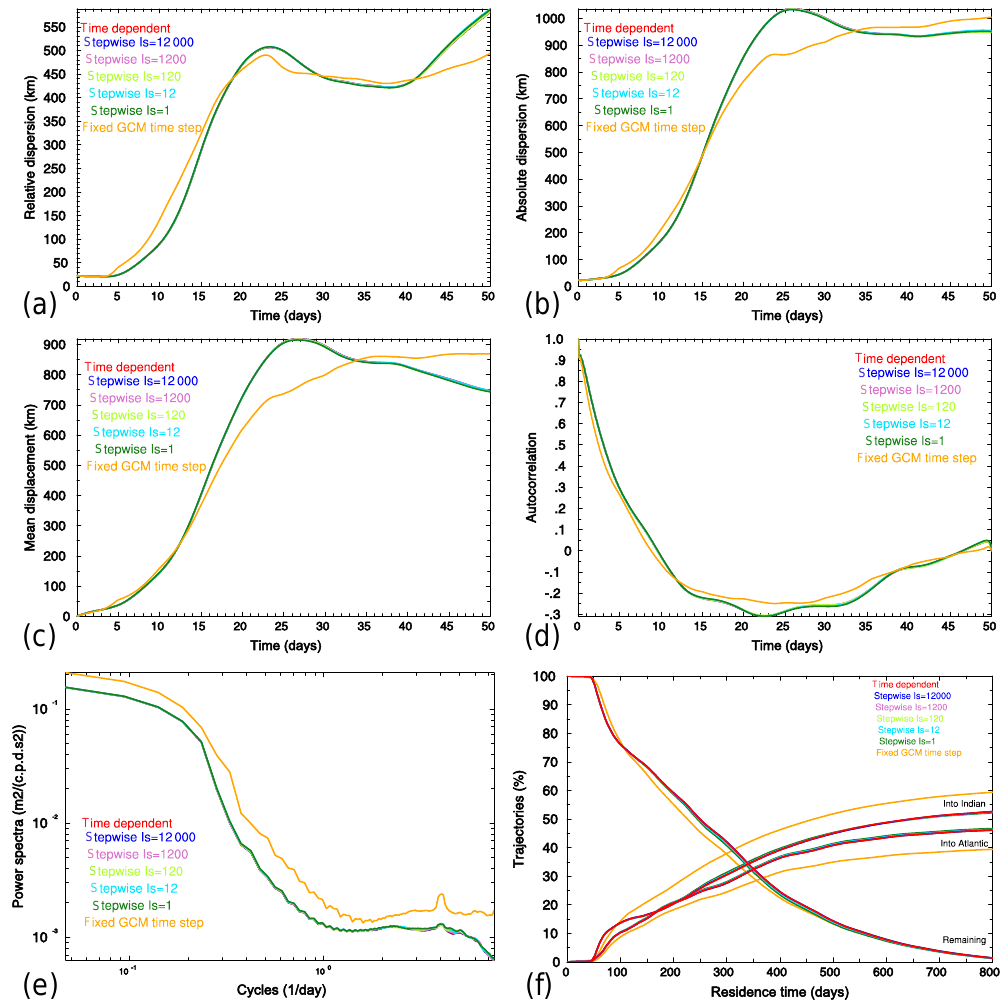
Figure 9. Lagrangian statistics of the ocean Agulhas trajectories. The relative dispersion (a) , the absolute dispersion (b) , the mean displacement travelled by the trajectory cluster (c) , the average Lagrangian velocity autocorrelation of the trajectories (d) and the average power spectra of the Lagrangian velocities (e) and the residence time evolution of the trajectory particles in the Agulhas region (f) are shown. Note that all statistics show very similar results, where only those based on the fixed GCM time step (orange curves) differ from the rest.